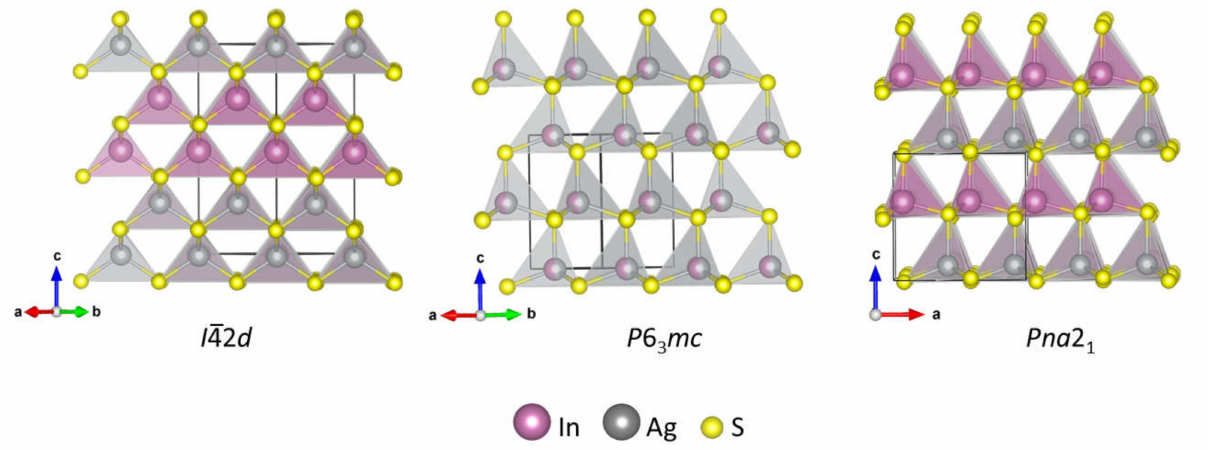
Figure 1. The crystal structures of the tetragonal, orthorhombic, and hexagonal polymorphs of AgInS 2 . Atoms are color-coded: In—purple, Ag—gray, S—yellow, and the site with mixed In/Ag occupancy is denoted as a half-purple and half-grey sphere. The unit cell is shown with a black line. The orientation is chosen to highlight similarities in the structures of